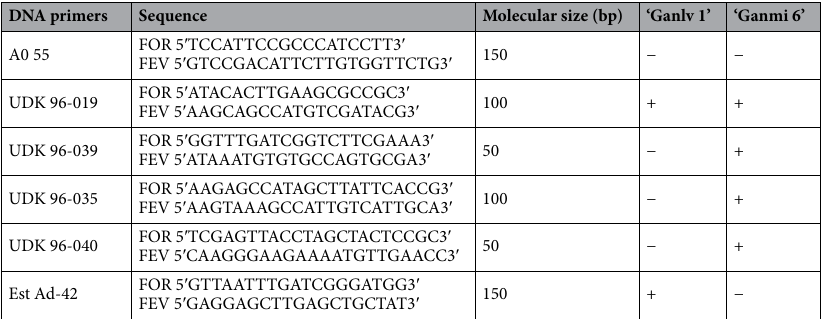
Table 3. Polymorphic SSR molecular makers used to discriminate two materials.